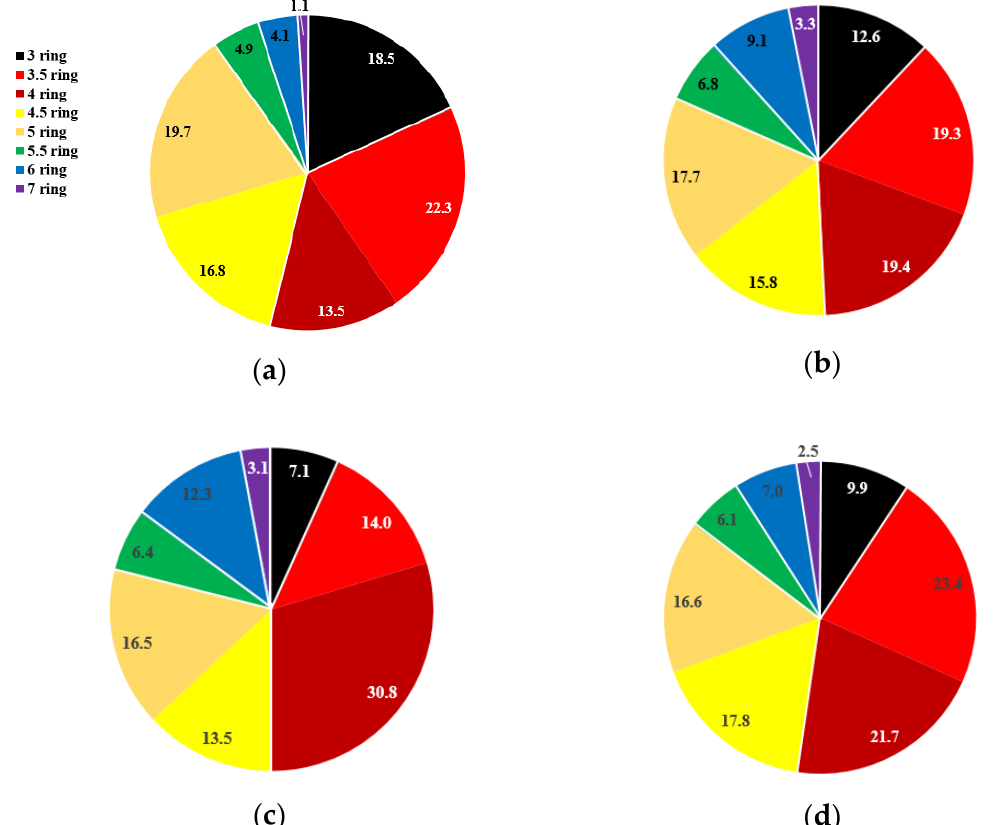
Figure 2. Percent of different ringed PAHs for each season: ( a ) Winter, ( b ) Spring, ( c ) Summer, and ( d ) Fall.